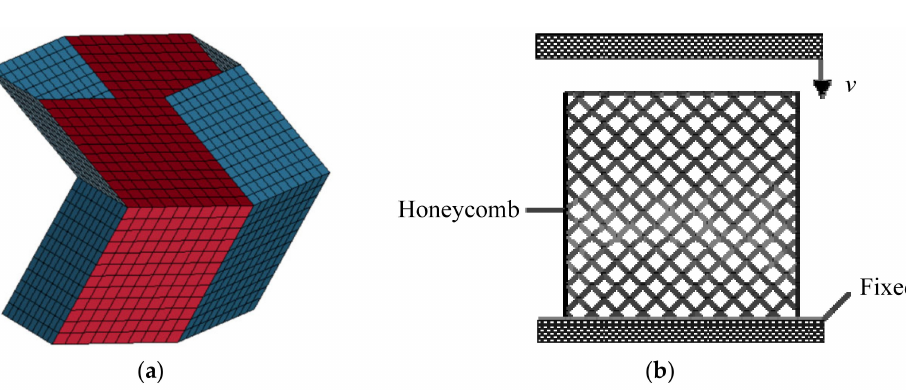
Figure 4. Finite element model of origami honeycomb: ( a ) mesh on unit cell, and ( b ) schematic of finite element